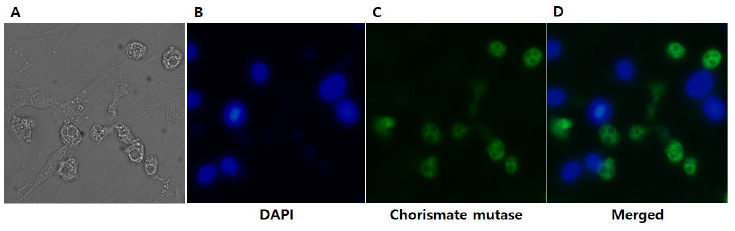
Fig 5. Immunocytochemistry using the A . castellanii chorismate mutase antibody. HCE cells cultured with A . castellanii trophozoites for 4 h were visualized under a fluorescent microscope. Bright-field (A), DAPI-stained (B), indirect immunocytochemical labeling (C), and merged images (D) were acquired at 400x magnification.